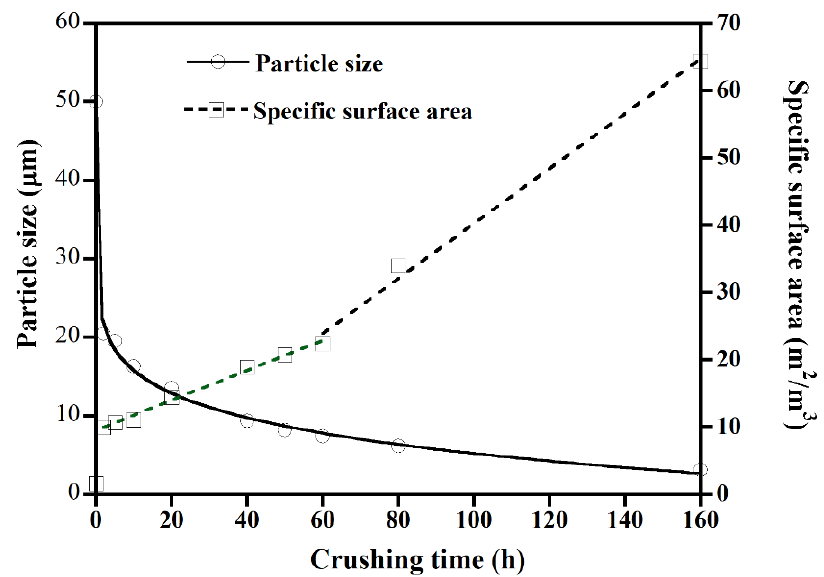
Figure 1. Diagram of the effect of crushing time on graphite particle size and specific surface area.